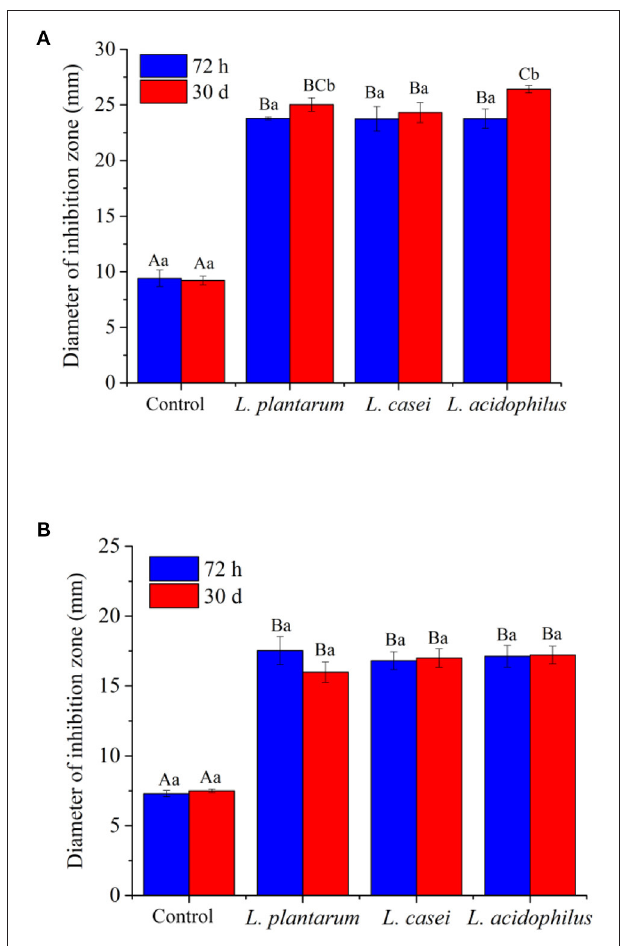
FIGURE 5 | The antimicrobial activity of unfermented and LAB-fermented apple juice against the growths of (A) E. coli and (B) S. aureus in vitro . Values with different letters within each samples indicated a significant difference in content ( p <